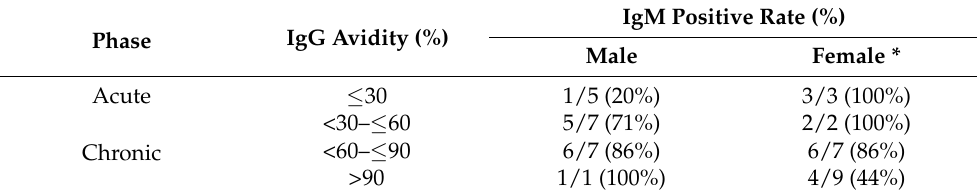
Table 2. IgG avidity and IgM positivity rate in IgG antibody-positive wild rats.